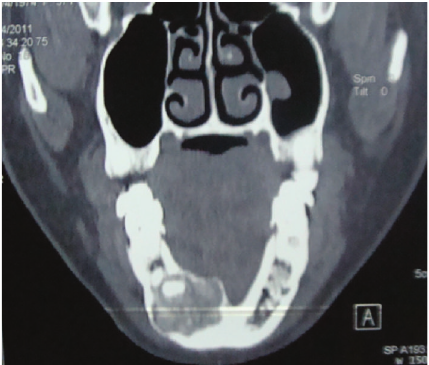
Figure 1: Axial CT image showing the lesion causing thinning and expansion of buccal as well as lingual cortical